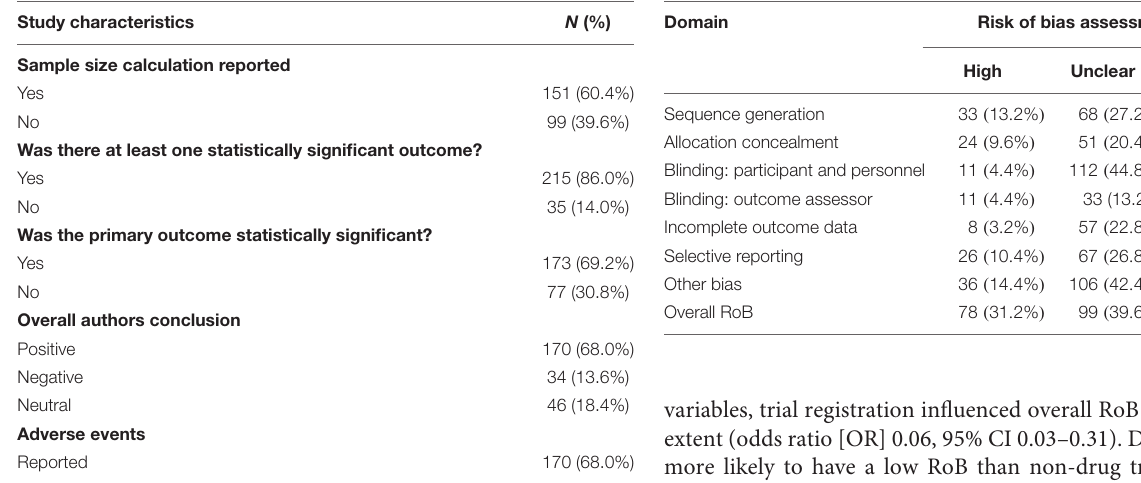
TABLE 2 | Risk of bias (RoB) assessments by domain ( N =